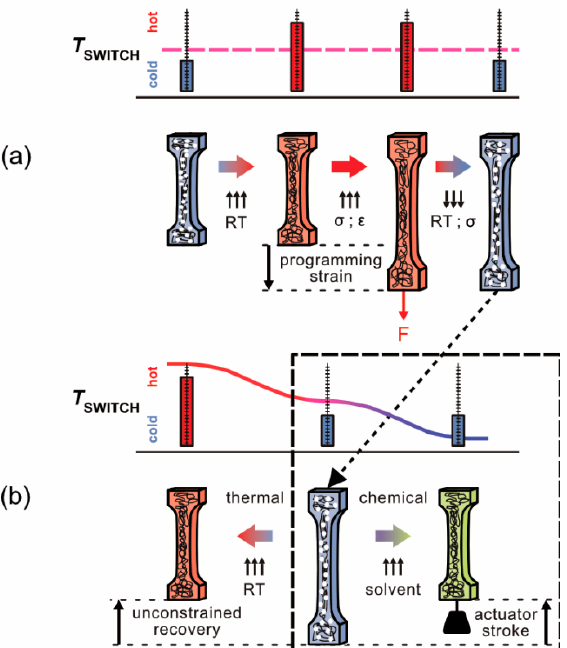
Figure 1. Shape memory polymer (SMP) programming and one-way effect. ( a ) Storage of entropic energy in a sequence consisting of heating to a temperature above the glass temperature of the molecular switch ( T SWITCH ), imposing the programming strain at this temperature, and constrained cooling of the material below T SWITCH . ( b ) Thermal (left) and chemical (right) triggering of the one-way effect. Thermal recovery is unconstrained (no end load). The chemically triggered one-way effect is exploited to lift an end load (actuation).